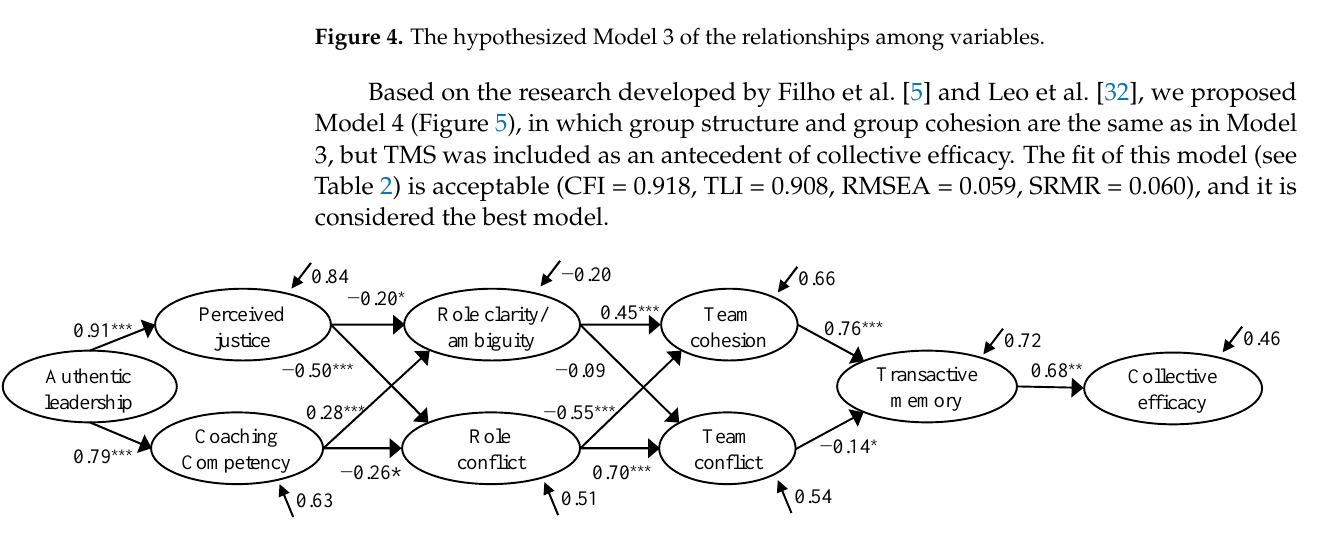
Figure 5. Structural equation model of the relationships among variables. * p < 0.05, ** p < 0.01, *** p < 0.001. Table 2. Fit Indices of the different models.